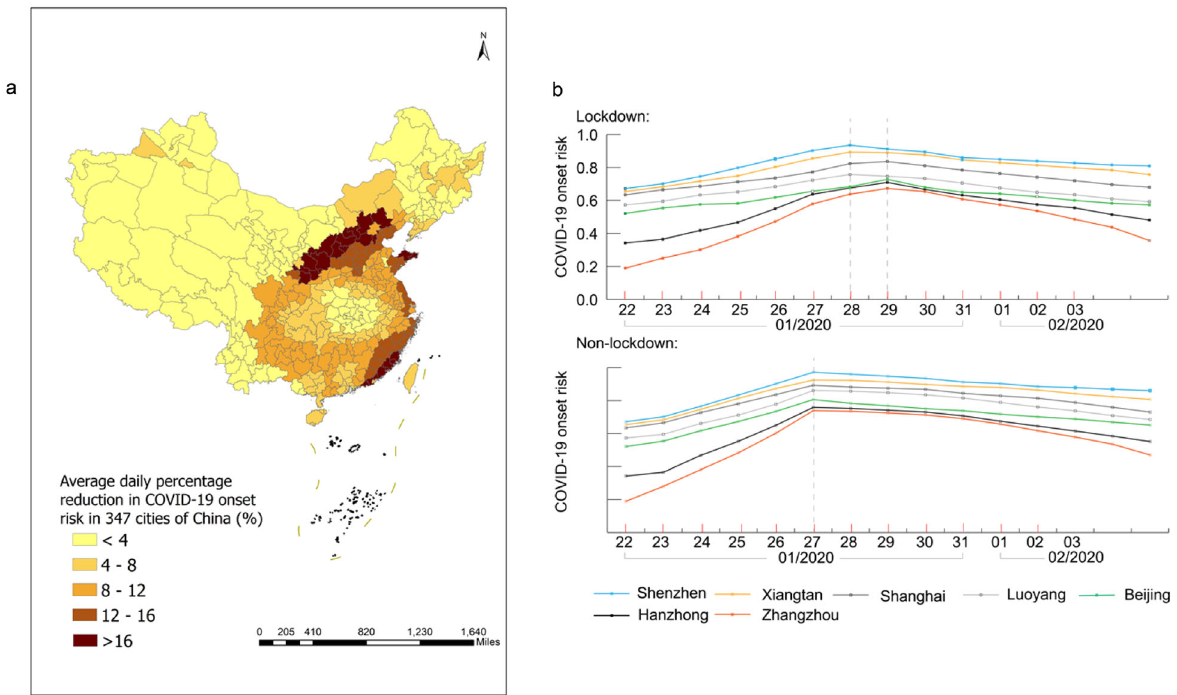
Fig. 3 The risk of COVID-19 symptom onset under two scenarios (i.e., with and without Wuhan lockdown measure) from 24 January to 5 February 2020. a Average daily percentage reduction in the onset risk in 347 Chinese cities in the lockdown scenario, compared with the non-lockdown scenario. b The onset risk under two scenarios in seven selected cities. The plotted values were computed from the predicted risk of COVID-19 symptom onset under the two scenarios resultant from the extended WKDE model, by using historical con fi rmed cases and inter-city human mobility data. Under the lockdown scenario, the outward human fl ows from Wuhan were regarded as not increasing the onset risk of other cities, due to the dramatic decrease in human mobility intensity, together with strict quarantine measures. Under the non-lockdown scenario, the human mobility intensity was estimated based on that of the corresponding time period in 2019 (see Methods section for